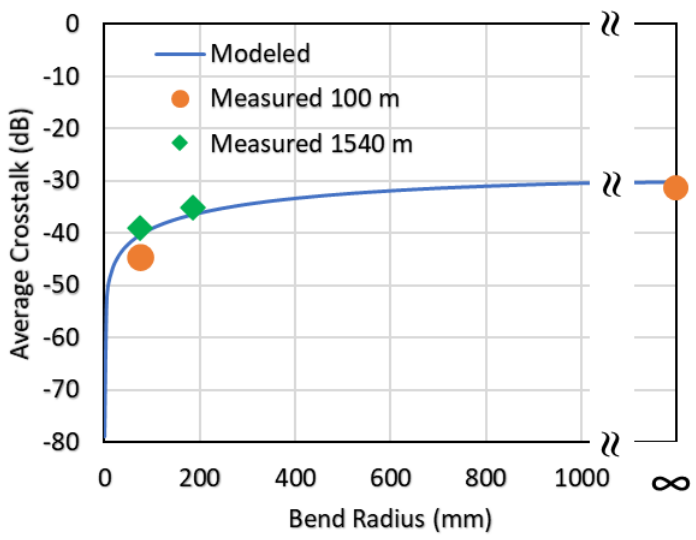
Figure 19. Comparison of measured and modeled crosstalk as a function of bend radius.